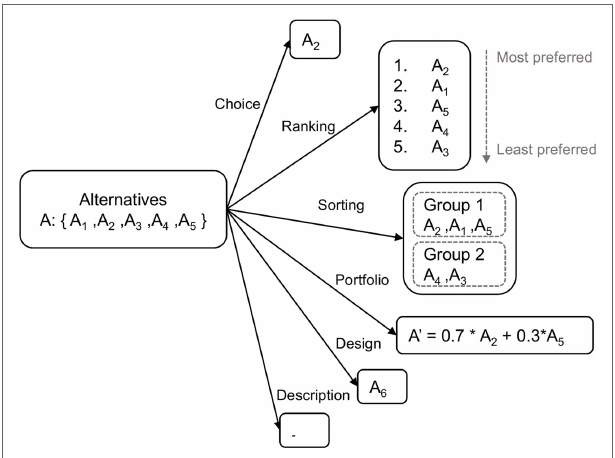
FiGURe 3 | Schematic overview of the multicriteria decision analysis problematics investigated in the review . Adapted from the studies by Belton and Stewart (2002) and Chen (2006)